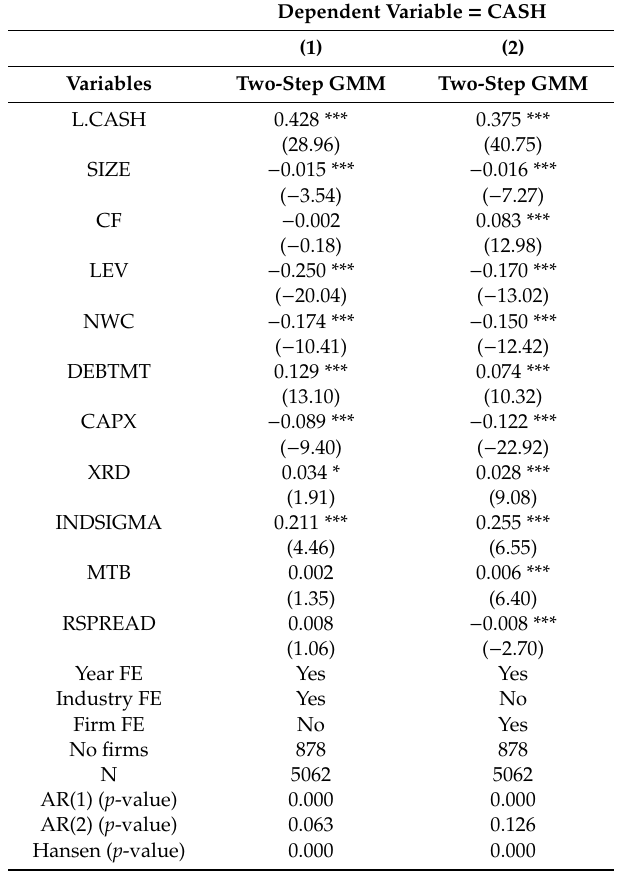
Table 10. Two-step system generalized method of moments